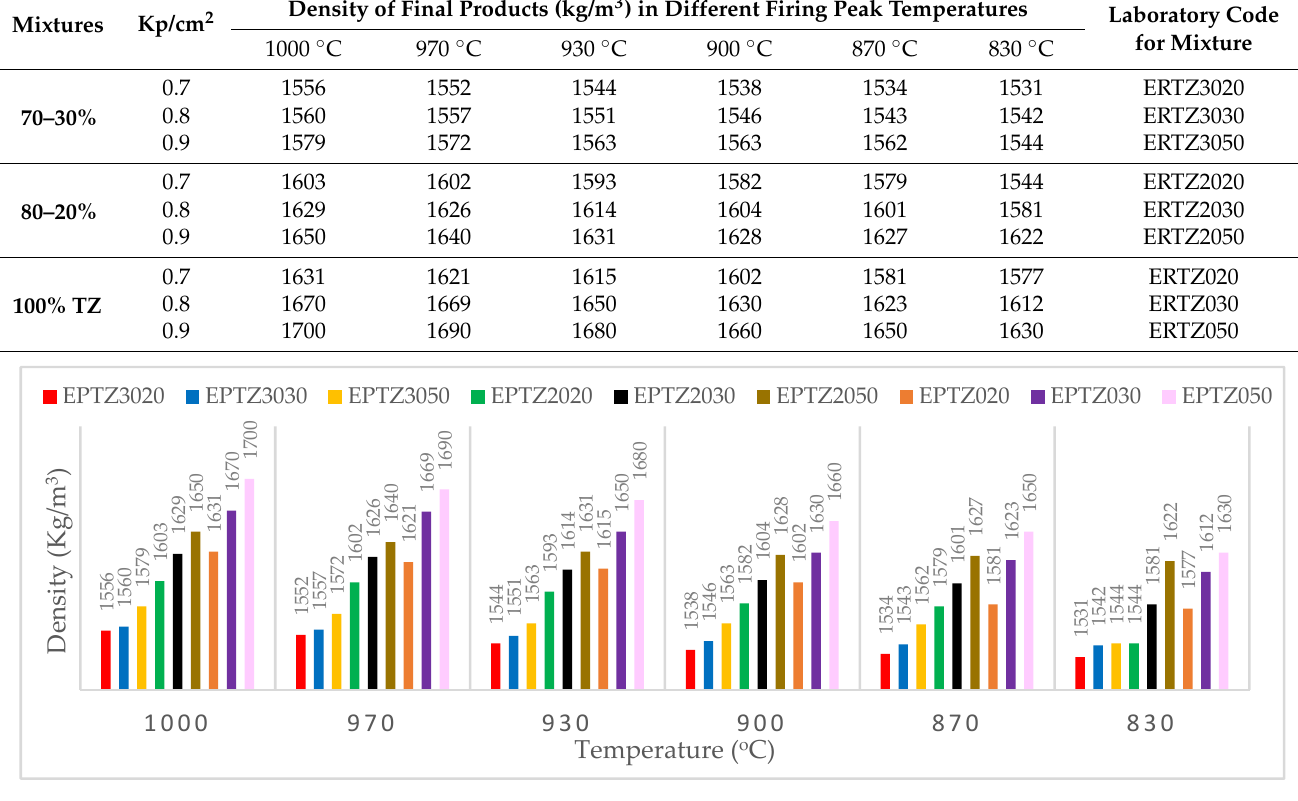
Table 7. Bulk density of the tested samples.